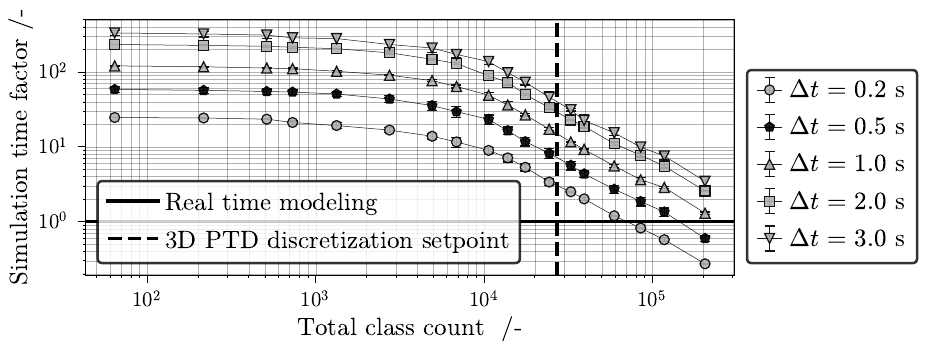
Figure A2. Simulation time factor in dependence of the total distribution class count for different time step sizes. Unity indicates a real-time measurement. Values greater than one factorize the simulation speed